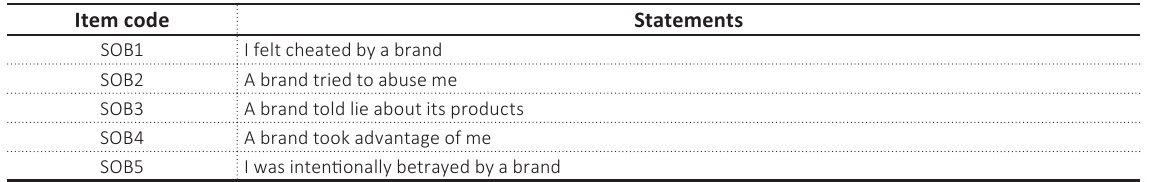
Table A1. Sense of online betrayal (SOB)